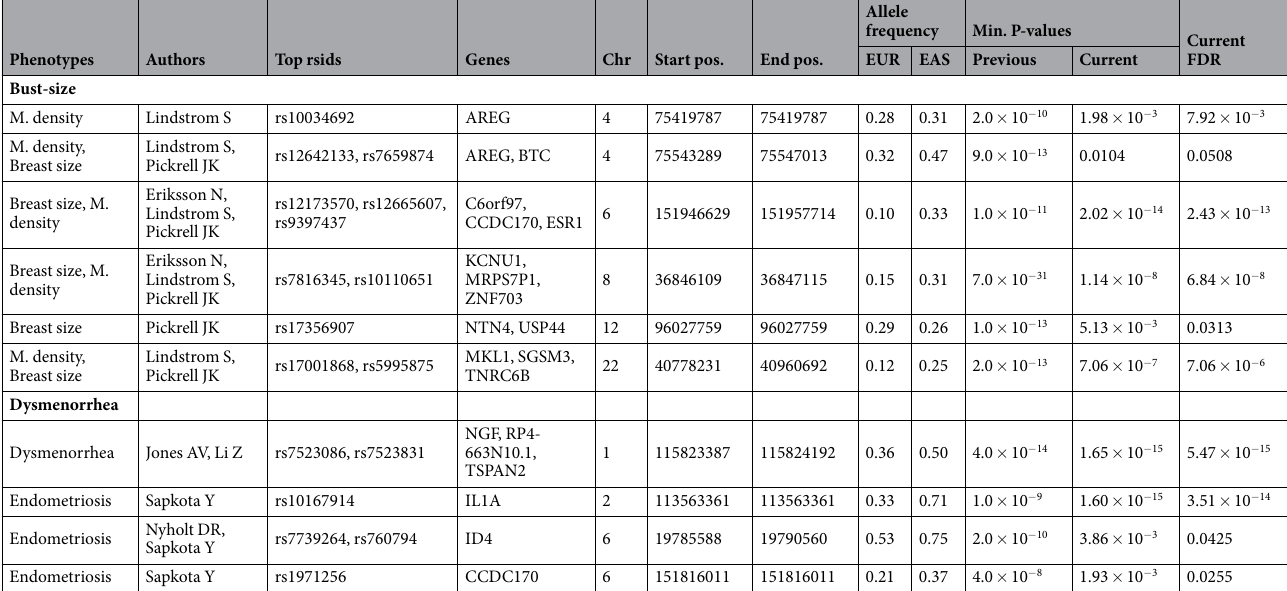
Supplementary Table S3). Notably, the recent dysmenorrhea association of rs76518691 in the ZMIZ1 gene from the Li et al . report did not replicate in our dataset 10 . Chr1:115.81–115.83 Mb NGF gene region locus.